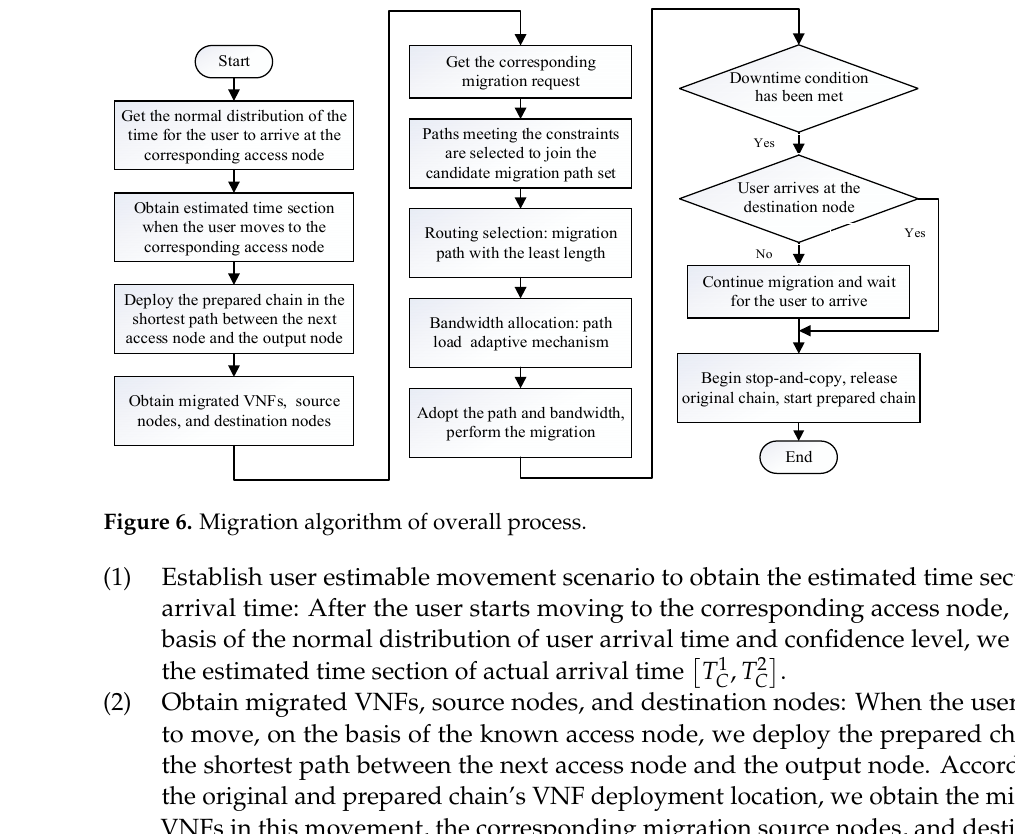
Figure 5. Copy dirty data repeatedly adopting pre-copy mode.